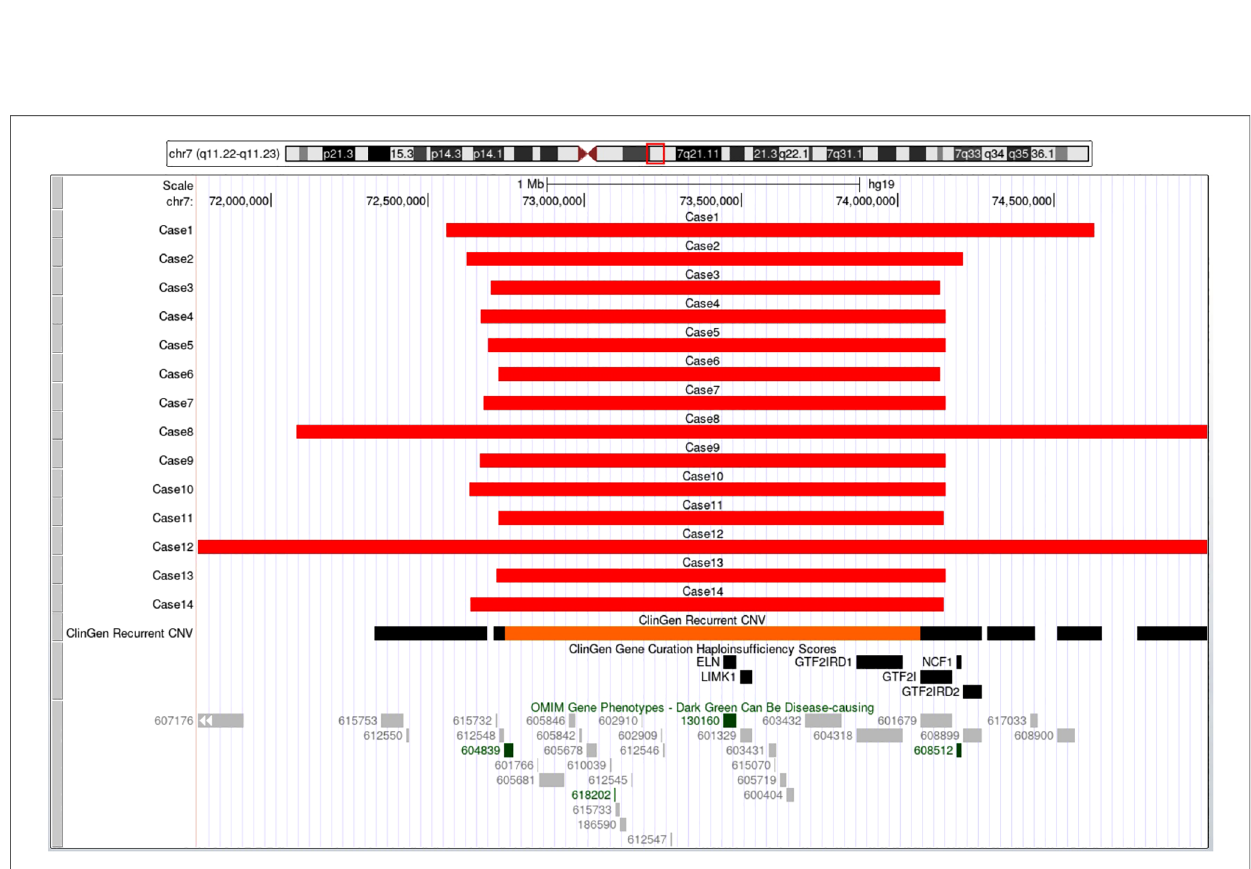
FIGURE 4 The breakpoints and covered genes of each microdeletion of the 14 fetuses, including the well-known OMIM disease-causing gene ELN (130,160) and NCF1 (608,512). Eleven cases had common deletion sizes ranged from 1.4 to 1.5 Mb. Case 1 had 2.1Mb deletions at 7q11.22-q21.11, involved 40 protein- coding genes including ELN (130,160). Case 8 had 5.5Mb deletions at 7q11.22-q21.11, involved 71 protein-coding genes including ELN (130,160). Case 12 had 21.4Mb deletions at 7q11.21-q21.11, involving 93 protein-coding genes, among which 82 genes including AUTS2 (607,270) and ELN (130,160) were OMIM